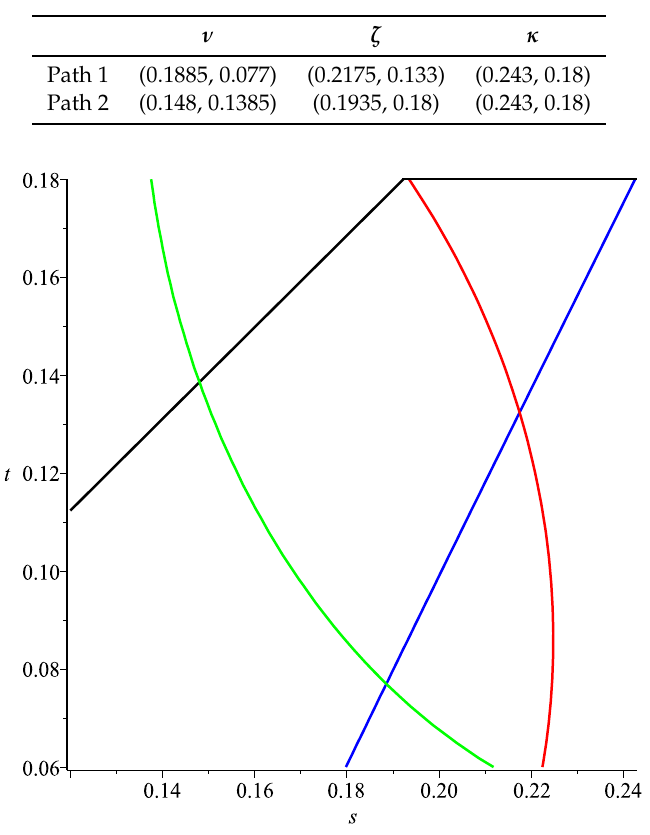
Figure 5. ζ (on red curve) and ν (on green